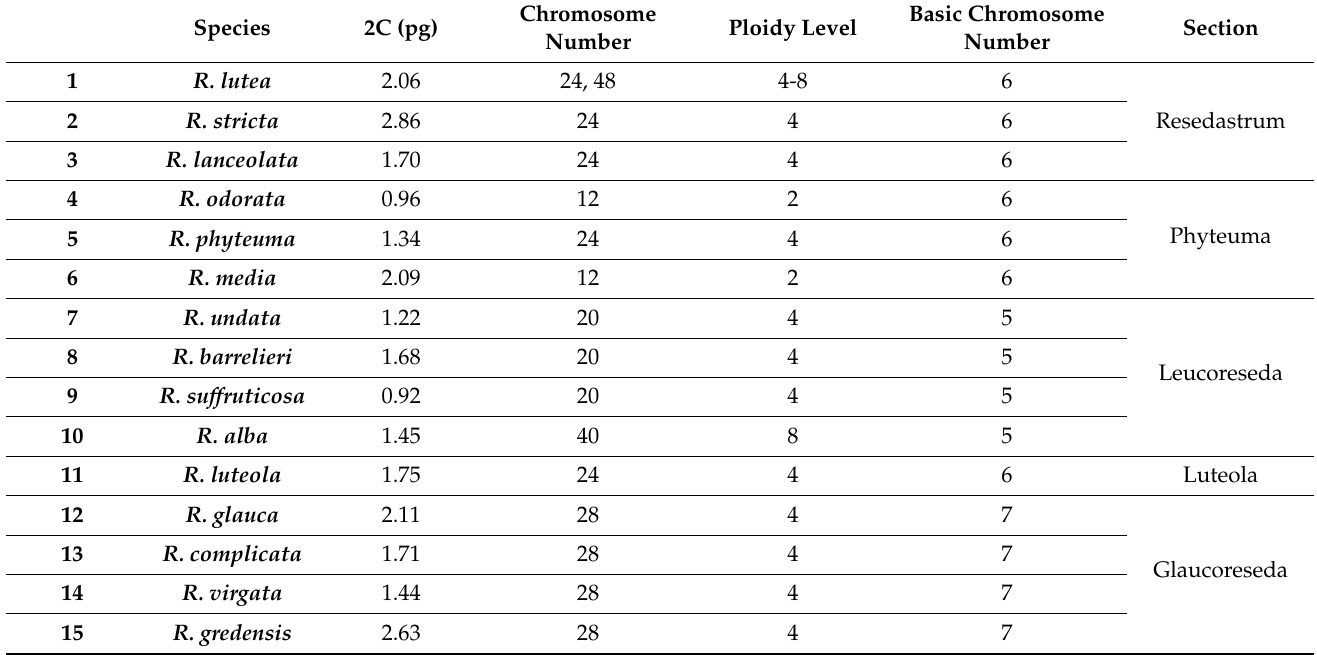
Table 2. Cytogenetical characteristics of Reseda species